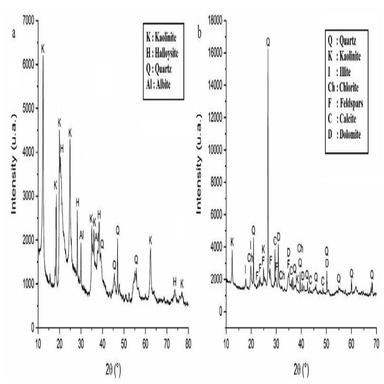
X-ray diffraction of the selected geomaterials in this study: (a): Kaolinitic clay; (b): Illitic clay.